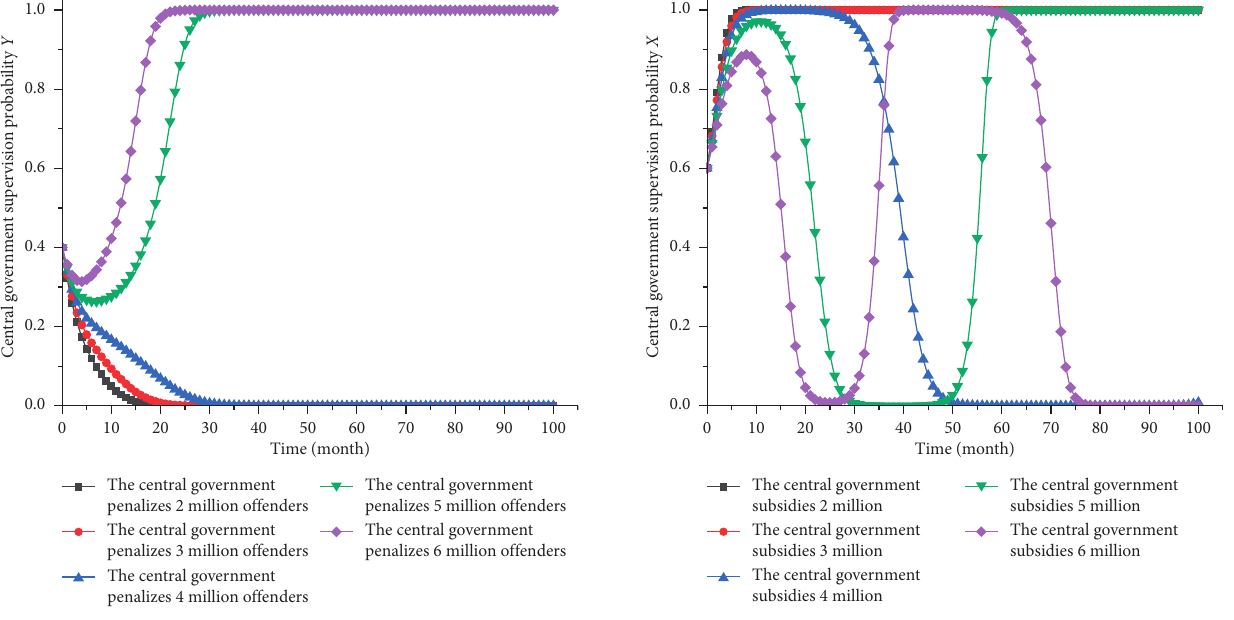
Figure 10: Impact of central fines on mining companies’ strategic choices.